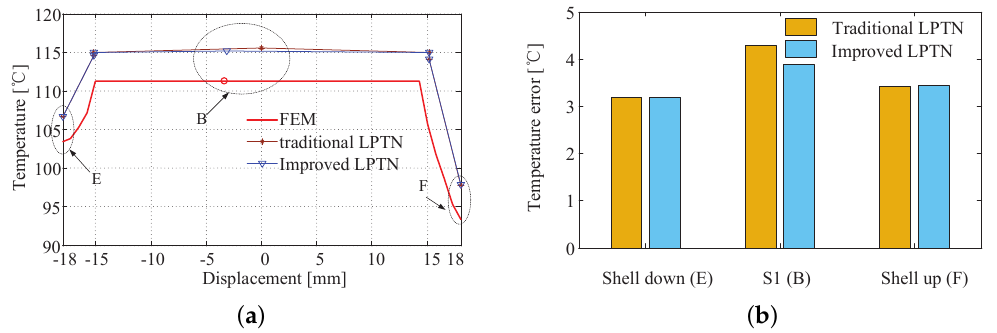
Figure 16. ( a ) Temperature distribution in z direction at 20 A. ( b ) Temperature error at several points.